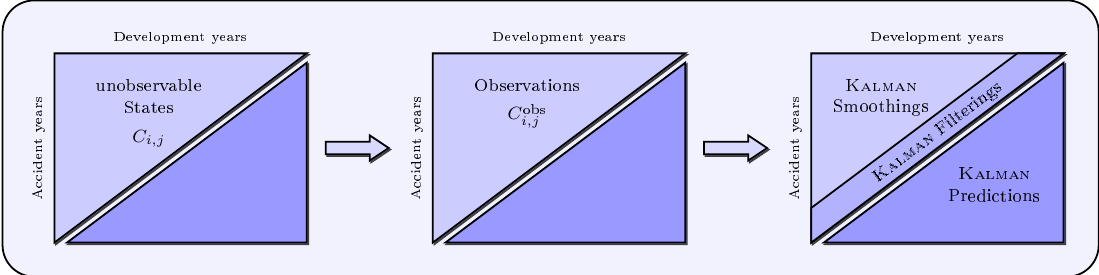
Figure 3. Unobservable states, observations and K ALMAN smoothings ( i + j < I ), K ALMAN filterings ( i + j = I ) and K ALMAN predictions ( i + j > I